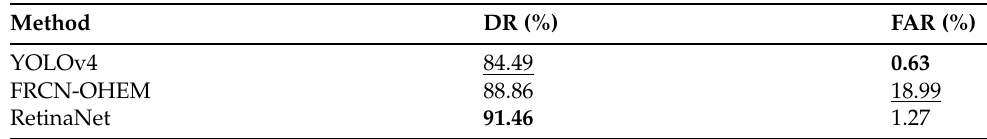
Table 6. Image-level detection result. The detection results of 316 images in the test set are counted. Red is the best, and blue is the worst. The results with underline are the worst, and the results with bold are the